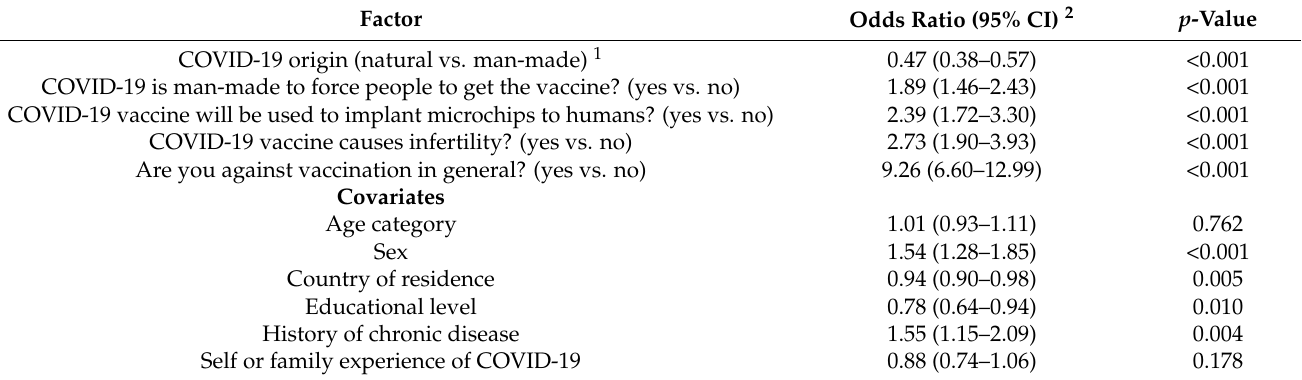
Table 4. Results of multinomial regression analysis of factors associated with vaccine acceptance.